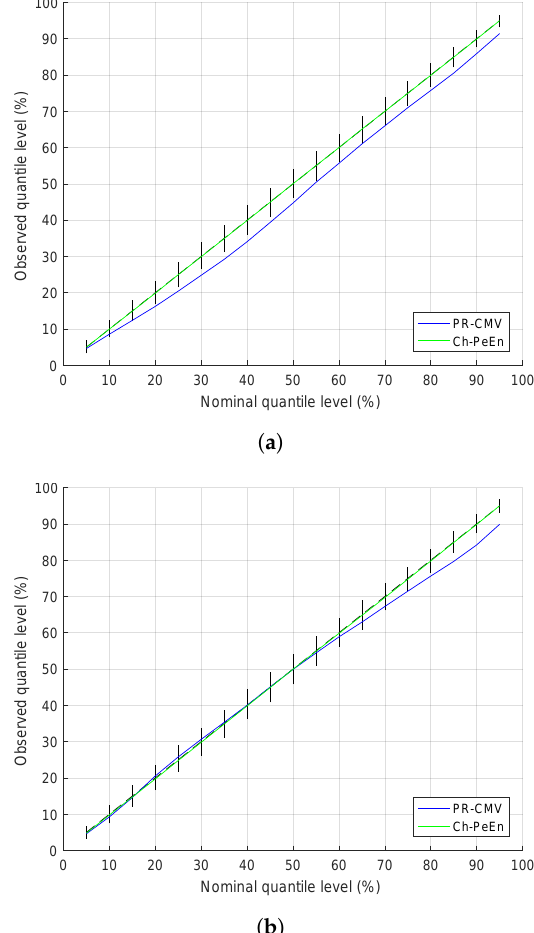
Figure 3. Reliability of the probabilistic forecast models CH-PeEn and Pr-CMV for the two sites, Carpentras ( a ) and Signes ( b